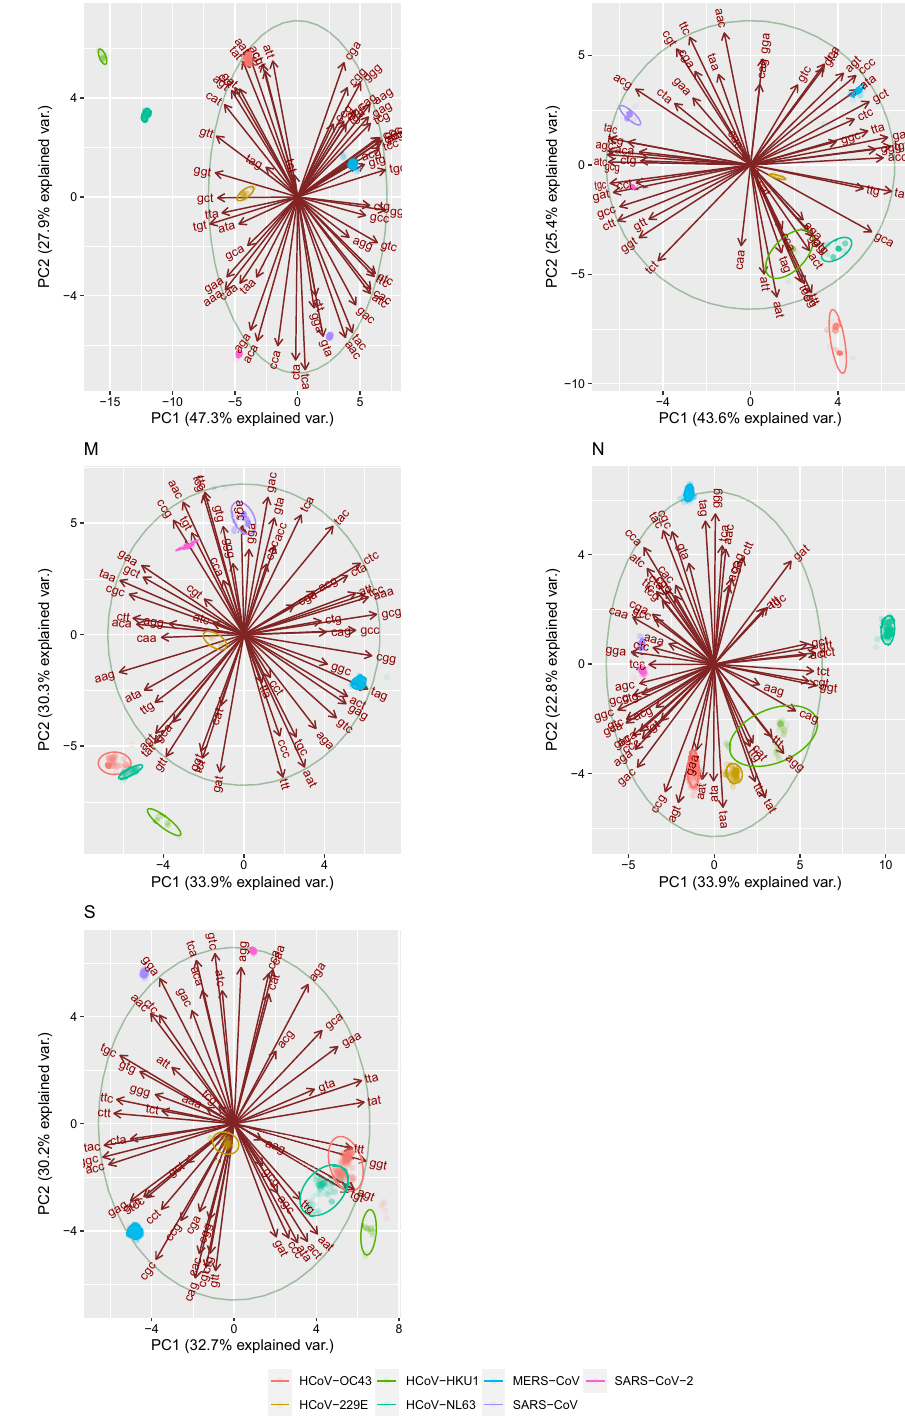
Figure 3. Scatter plot based on the first two components of the PCA performed on RSCU. The different proteins are reported in separate cells while viral species are color-coded. The loadings are represented as arrows and the corresponding correlation circle has been reported. The 95% confidence ellipses around clusters are also reported. A more detailed representation is provided in Supplementary figures